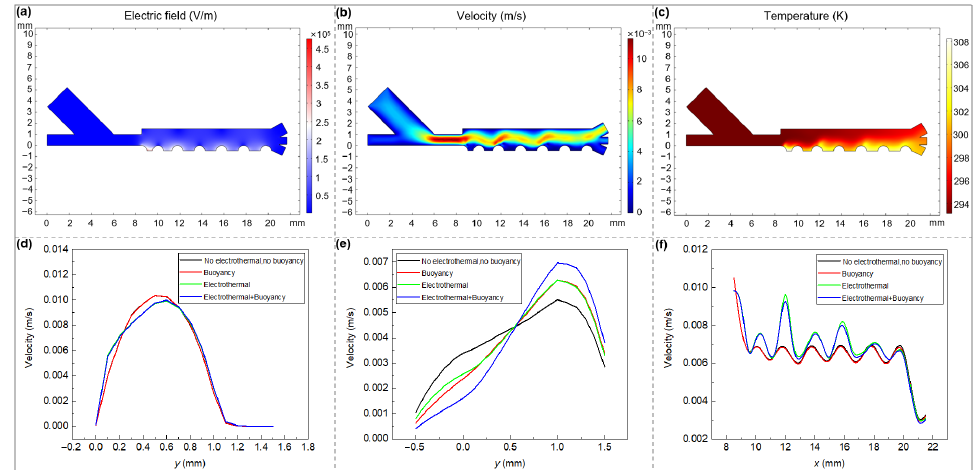
Figure 2. Numerical calculation of the distribution of: ( a ) Electric field, ( b ) Flow field, ( c ) Temperature field under an optimal operating condition that allows fractionation of PS particles: U 0 = 152 V eff , f = 100 kHz, σ m = 0.001 S/m, u 1 = 2.5 mm/s, u 2 = 1.5 mm/s; influence of electrothermal and buoyancy forces on the magnitude of the fluid velocity at different x and y positions: ( d ) x = 8.55 mm ( e ) x = 20.6 mm ( f ) y = 0.5 mm.